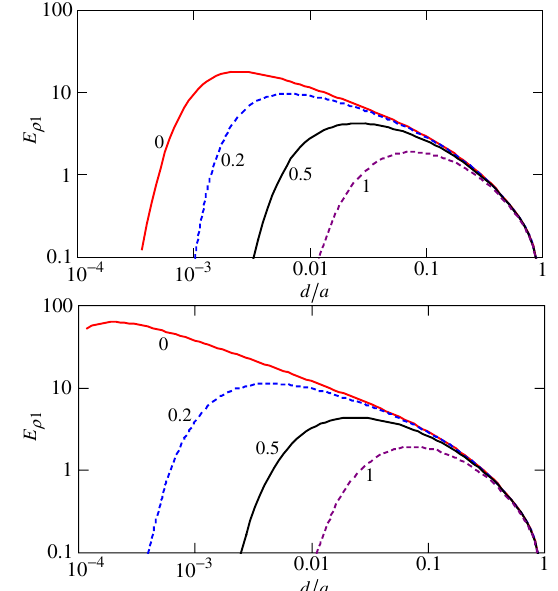
FIG. 6. Dependency of the radial electric field amplitude ð KV = m Þ at (cid:6) ¼ b (cid:1) 0 on the relative layer thickness d=a E (cid:6) 1 for a ¼ 5 mm , " ¼ 4 , j q j ¼ 1 pC , (cid:1) ¼ 20 (top) and (cid:1) ¼ 70 (bottom); the magnitudes of (cid:4) (mm) are given near the